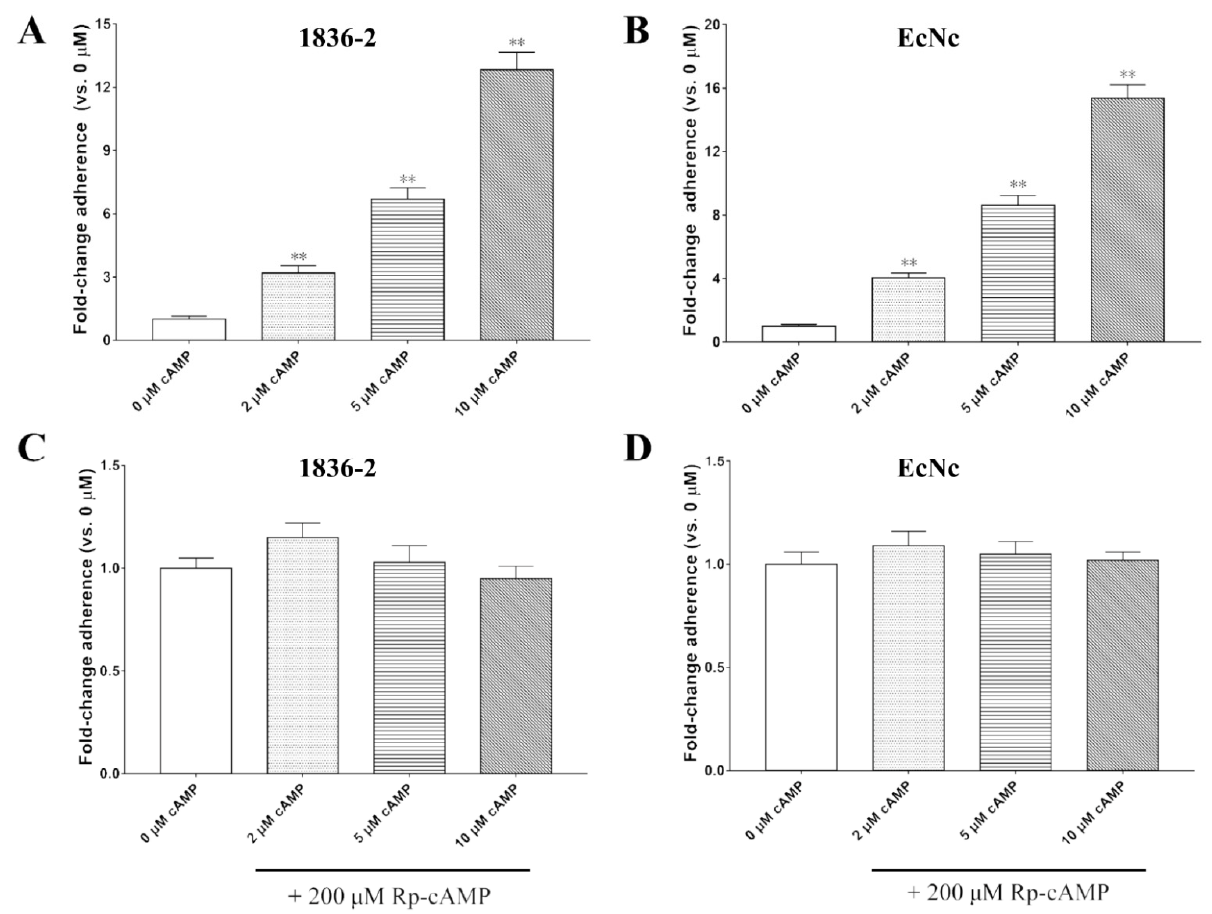
Figure 4. Exogenously supplied cAMP enhances bacterial adherence in a concentration-dependent manner. ( A ) Pre-incubated with 2, 5, and 10 μ M cAMP increases the adherence ability of 1836-2 strain adhesion to IPEC-J2 cells in a concentration-dependent manner. ( B ) Exogenously supplied with 2, 5, and 10 μ M cAMP promotes E. coli EcNc strain adhesion to Caco-2 cells. ( C ) Pre-treated 200 μ M Rp-cAMP block the efficacy of cAMP on promoting ETEC 1836-2 strain adhesion to IPEC-J2 cells. ( D ) Pre-treated with 200 μ M Rp-cAMP block efficacy of cAMP on promoting E. coli EcNc strain adhesion to Caco-2 cells. Data are expressed as mean ± SD of triplicate experiments. * indicates p < 0.05 and is deemed statistically significant. ** indicates p < 0.01 and is deemed statistically highly significant.